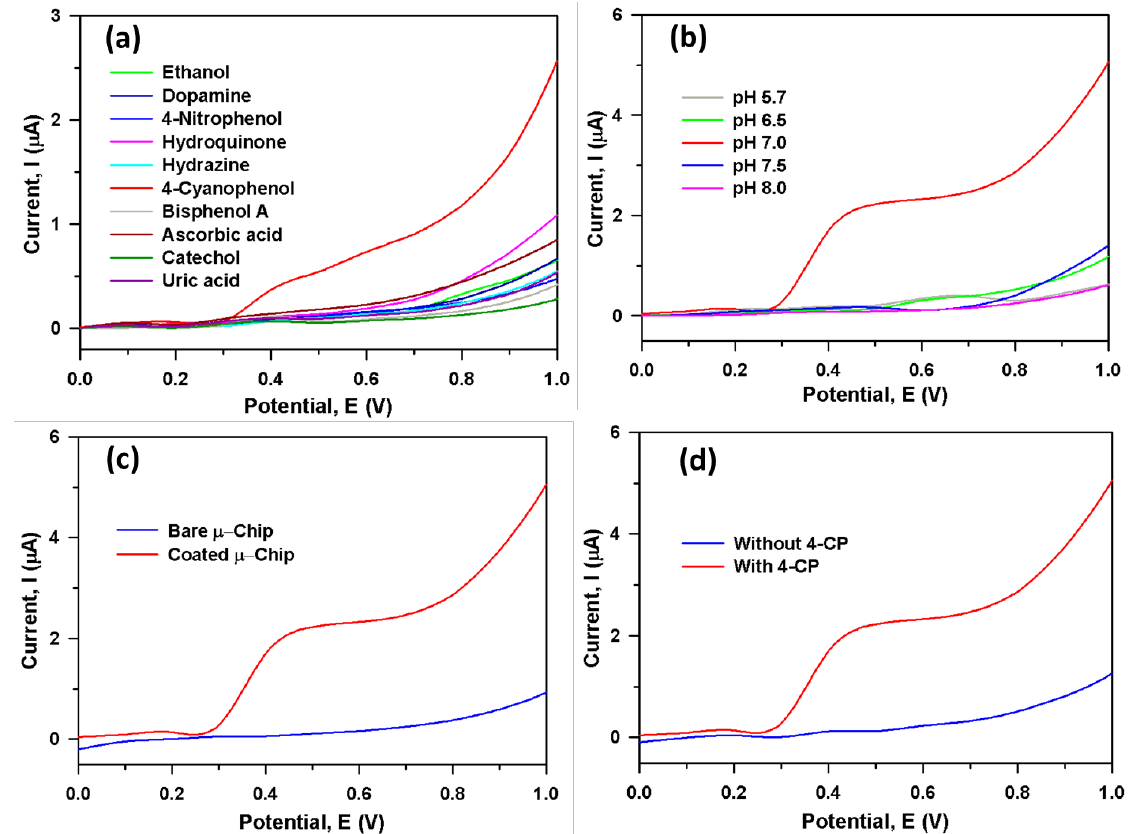
Figure 3. Current response from 2.0 µM; 25.0 µL using the CGO/PEDOT:PSS/Au / μ -Chip electrode: ( a ) Selectivity study of ten interfering chemicals, ( b ) pH optimization, ( c ) Au/ μ -Chip and CGO/PEDOT:PSS/Au / μ -Chip electrode and ( d ) Without and with the presence of 4-CP.